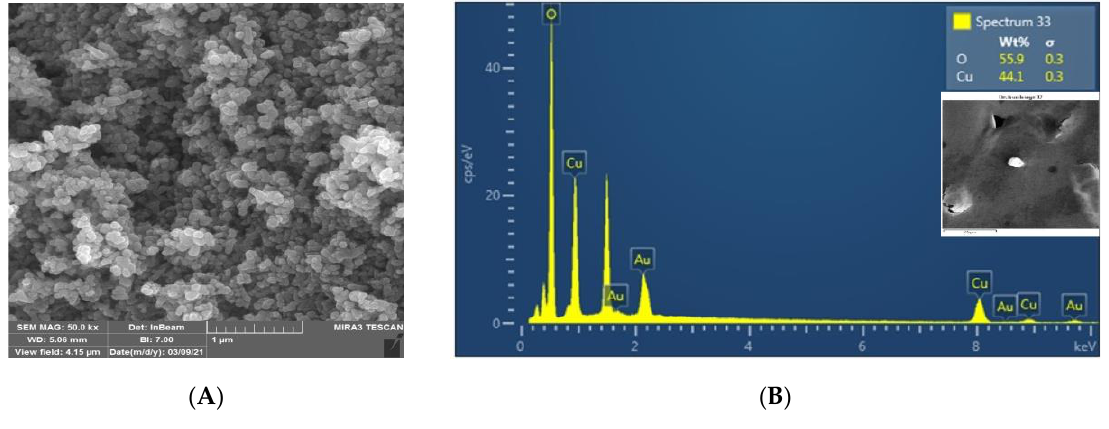
Figure 6. ( A ) The shape of synthesized CuO @OVLe NCs assessed utilising SEM (scale bar = 1 µm); ( B ) EDX profile.